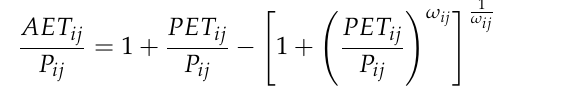
Figure 2. Work flow of the study.